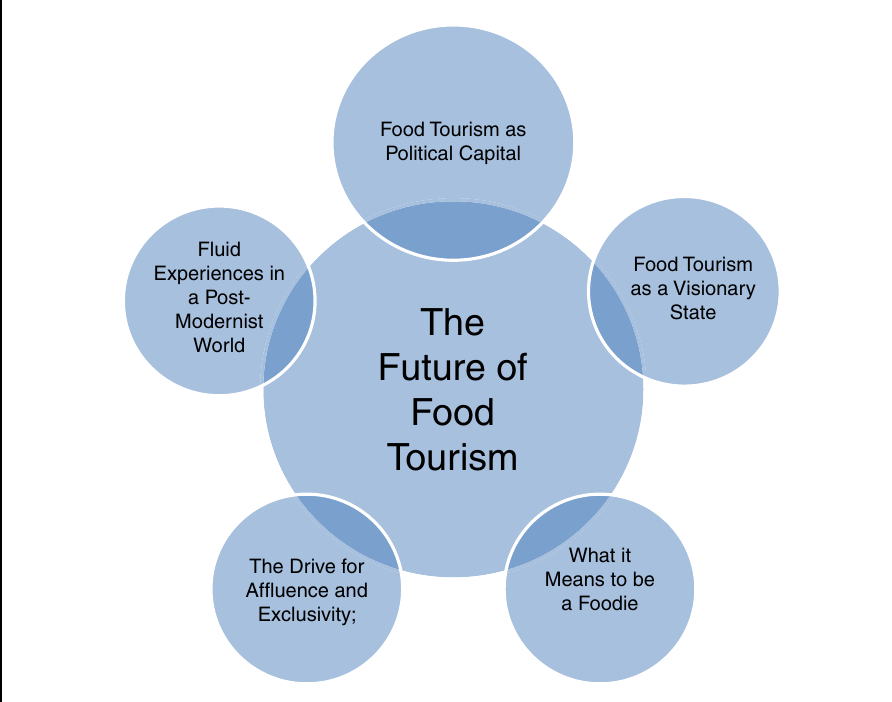
Figure 1 Drivers shaping the future of food